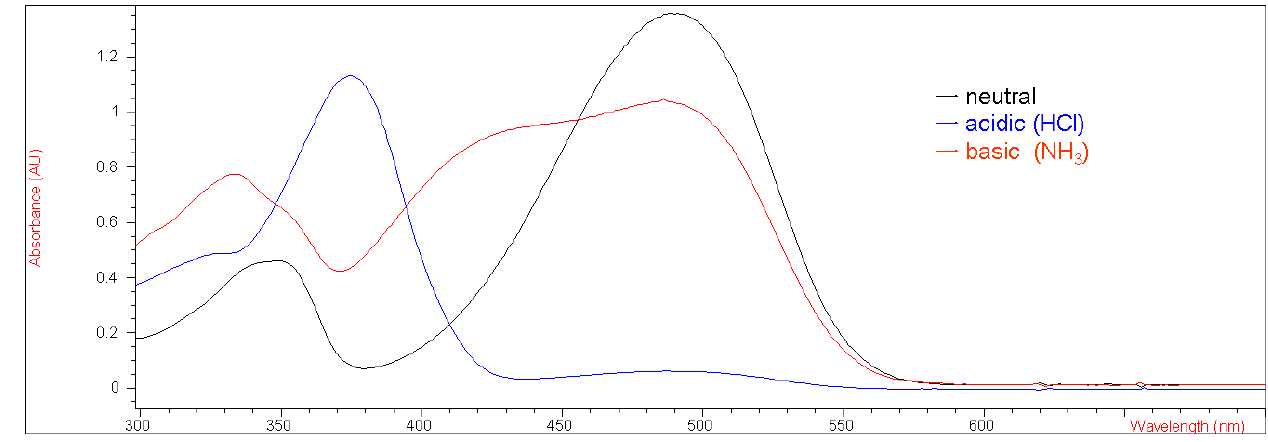
Cl ) under neutral, basic and acidic 2 2